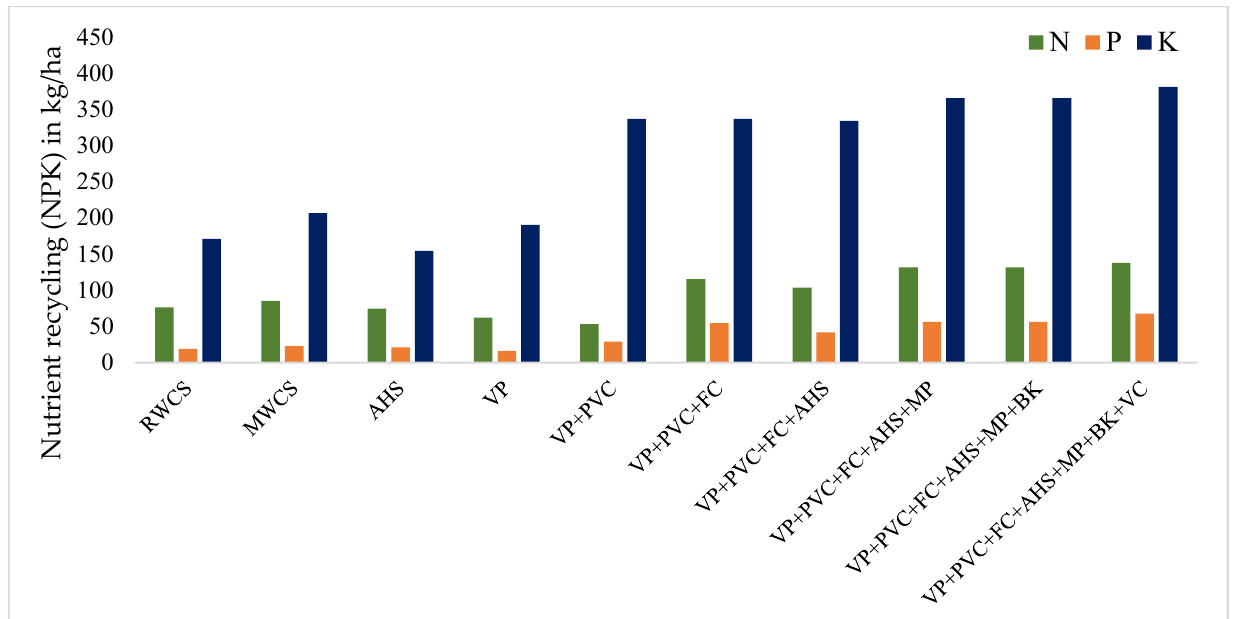
Figure 3. Nutrient addition in soil under different modules of the integrated farming system. RWCS: